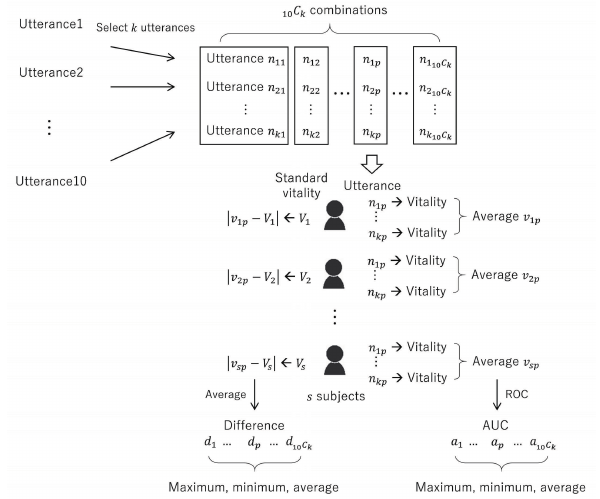
Figure 1. Details of utterance